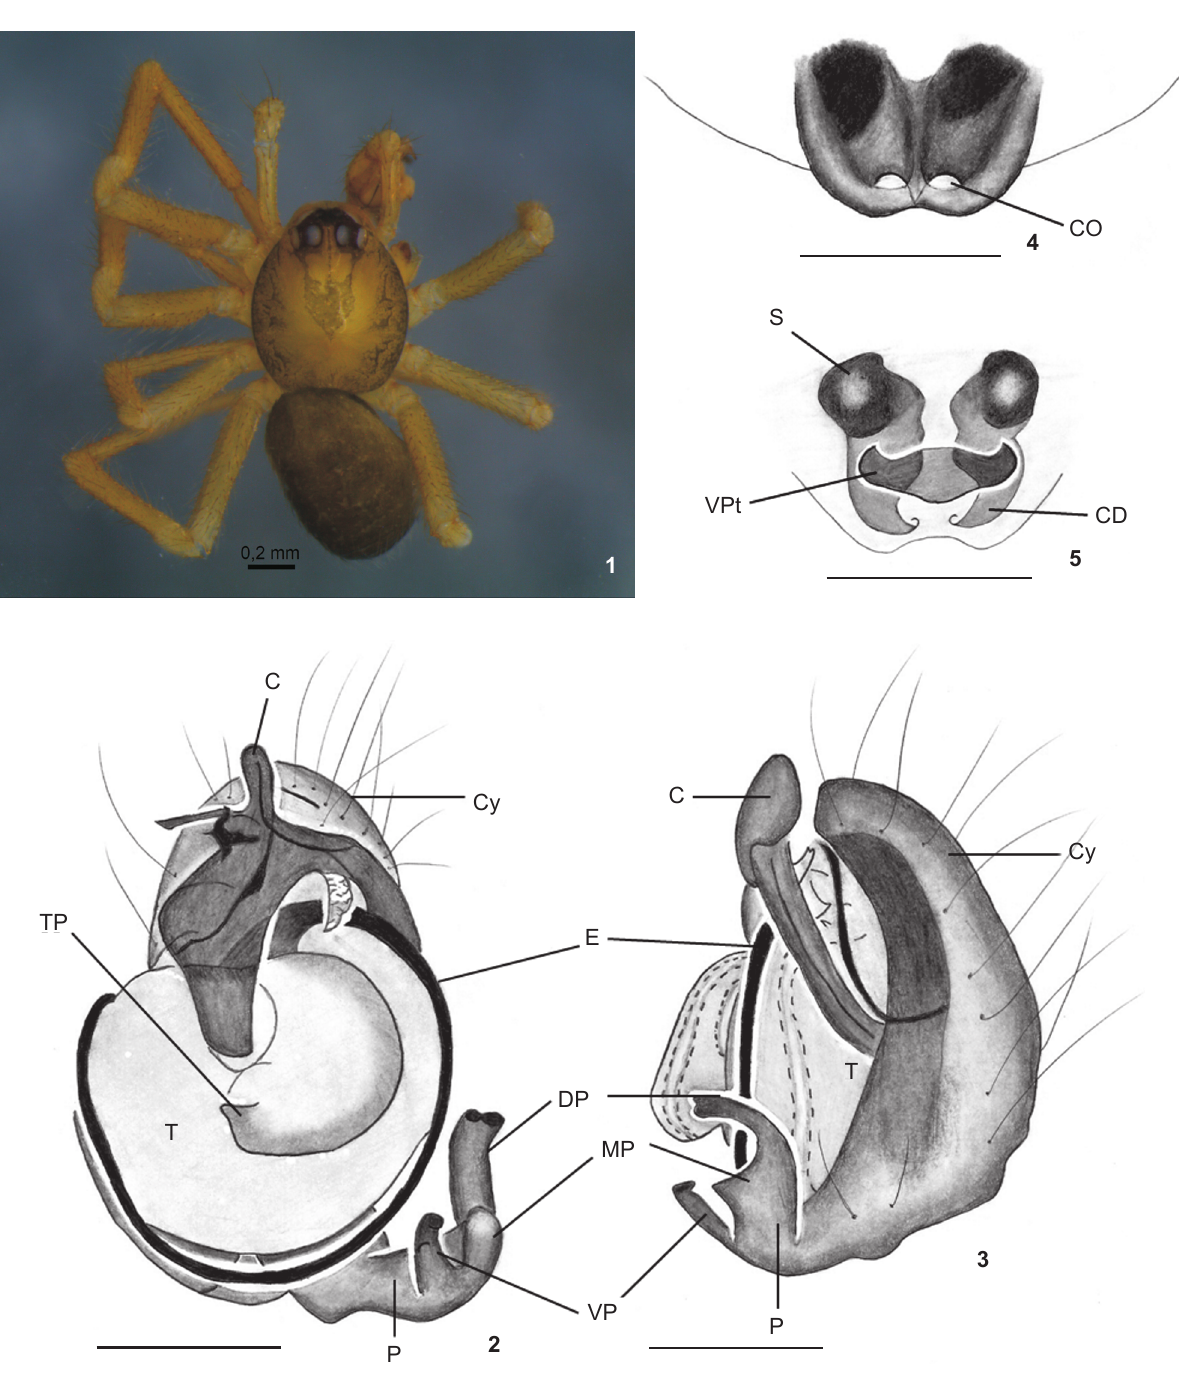
Figures 1-5. Nesticus ivone sp. nov. : (1-3) male holotype: (1) dorsal view; (2) left palpus, ventral view; (3) ditto, retrolateral view; (4-5) female paratype: (4) epigynum, ventral view; (5) female internal genitalia, dorsal view. (C) Conductor, (CD) copulatory duct, (CO) copulatory opening, (Cy) cymbium, (DP) paracymbium dorsal process, (E) embolus, (MP) paracymbium median process, (P) paracymbium, (S) spermathecae, (T) tegulum, (TP) tegular process, (VP) paracymbium ventral process, (VPt) vulval plate. Scale bars: 0.1 ZOOLOGIA 28 (2): 247–249, April, 2011